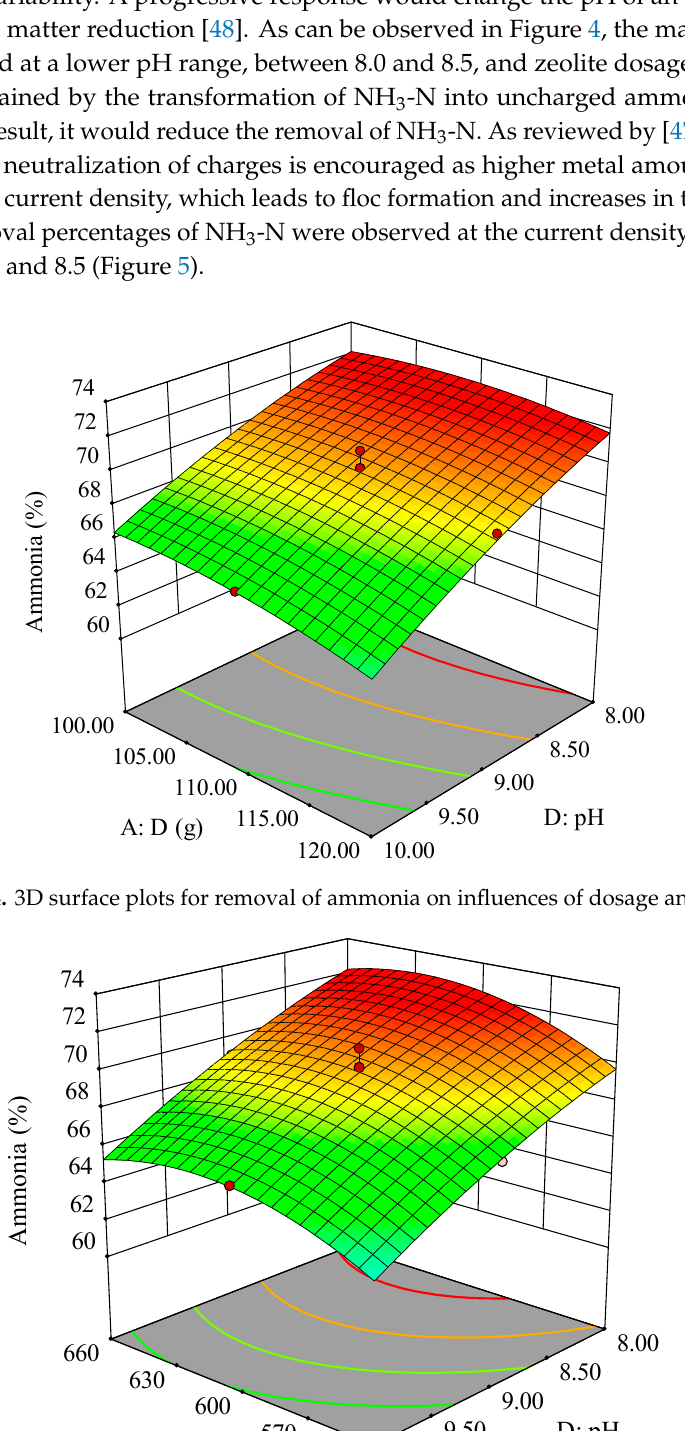
Figure 6. 3D surface plots for removal of ammonia on influences of electrolysis time and pH. According to [54,55], the removal efficiency of adsorbents increase when increasing the adsorbent dosage, leading to the accessibility of the active surface area. This fact is in agreement with the results from this study, which exhibited that higher percentage removal of NH 3 -N was achieved with increasing zeolite dosage in the range of 105–115 g versus electrolysis time of 57–61 min, as illustrated in Figure 8. Furthermore, Figure 9 clearly shows that the maximum reduction of NH 3 -N occurred in the range of 600–630 A/m 2 current density and at electrolysis duration between 59 and 63 min. This phenomenon can be described by a rise in the Al 3+ charged cations and thus releasing